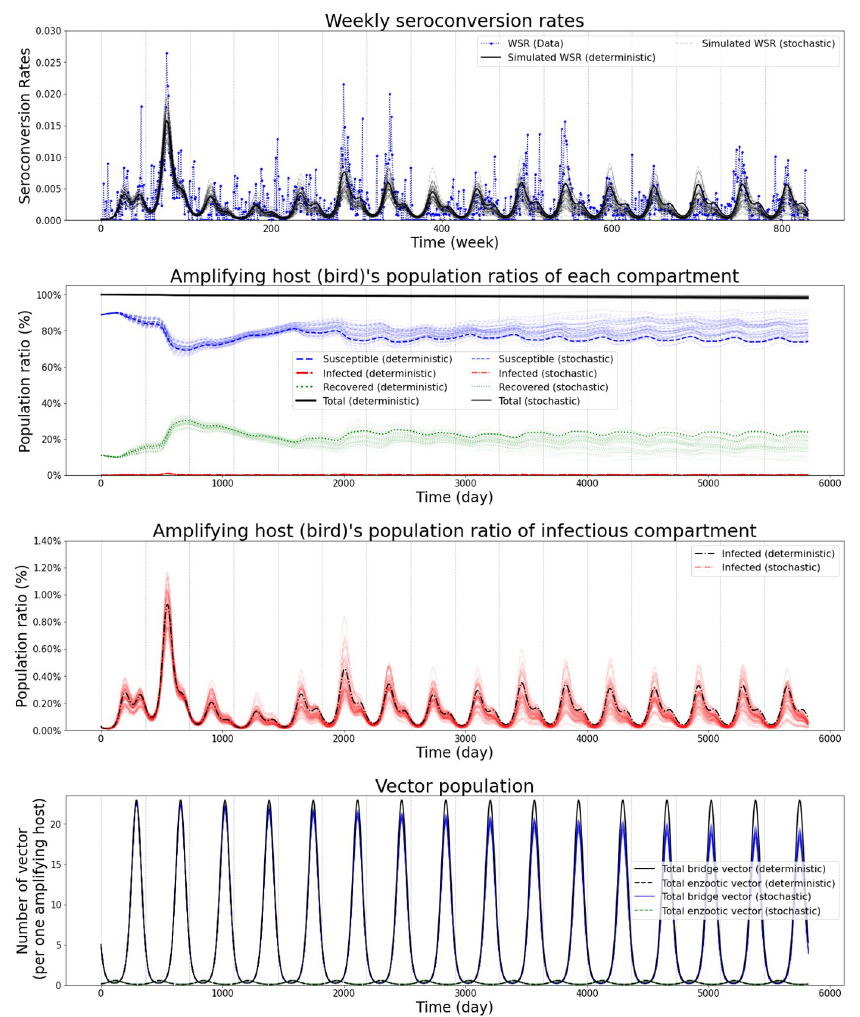
Fig 3. Simulation result. Simulation results of the deterministic model and stochastic model (50 instances). The 1st plot presents the weekly seroconversion data points (blue) and the simulated seroconversion rates in the two models. The remaining plots describe the population changes over time in the amplifying host compartment (2nd and 3rd) and the vector compartments (4th).